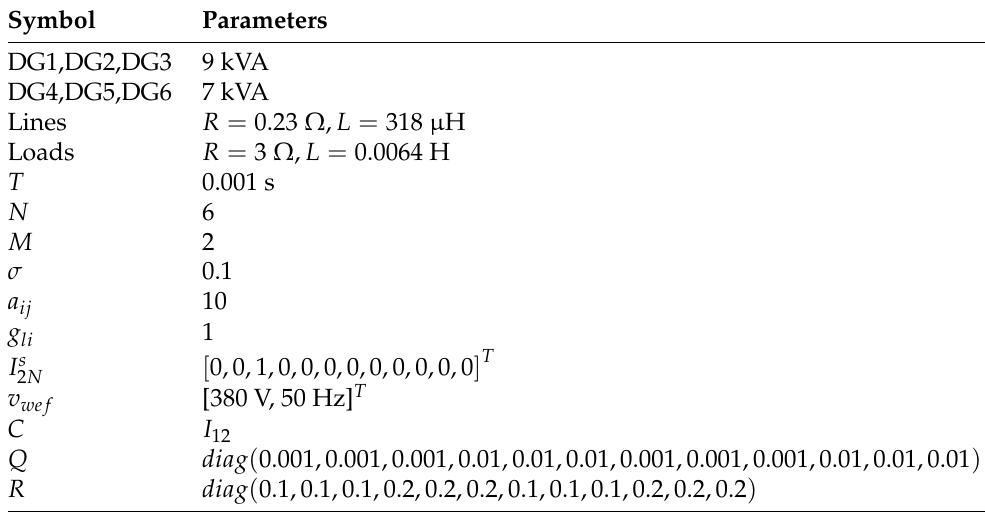
Table 1. Setting of the test seaport microgrid and Algorithm